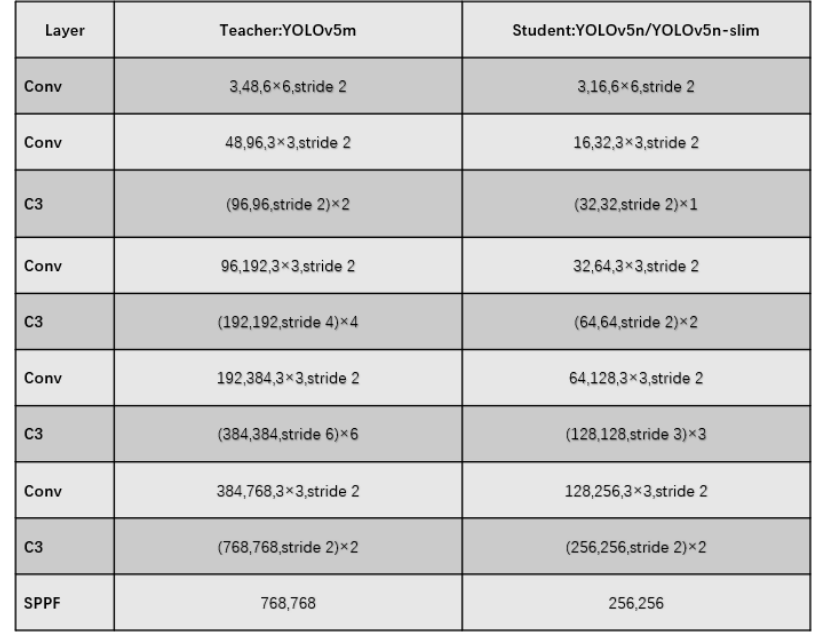
Figure 9. Comparison of teacher model and student model.